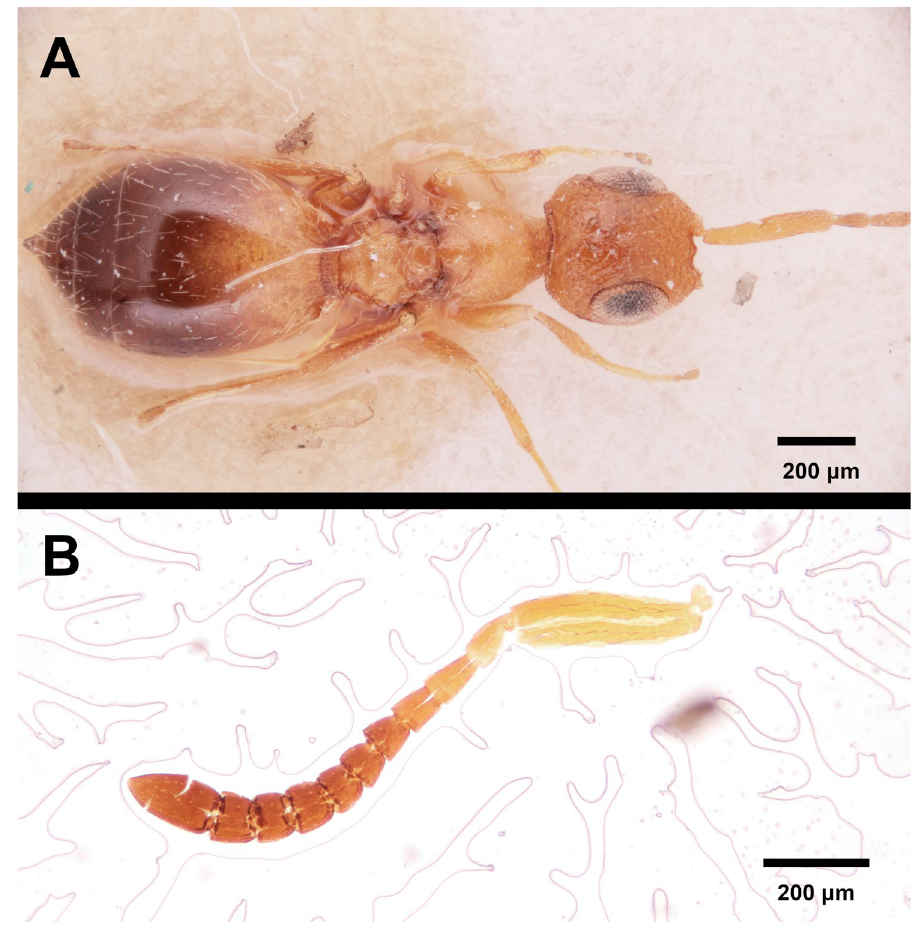
Fig. 18. Conostigmus grangeri (Dessart & Masner, 1965), holotype, ♀. A . Dorsal view (MNhN EY25339). B . right antenna (MNhN